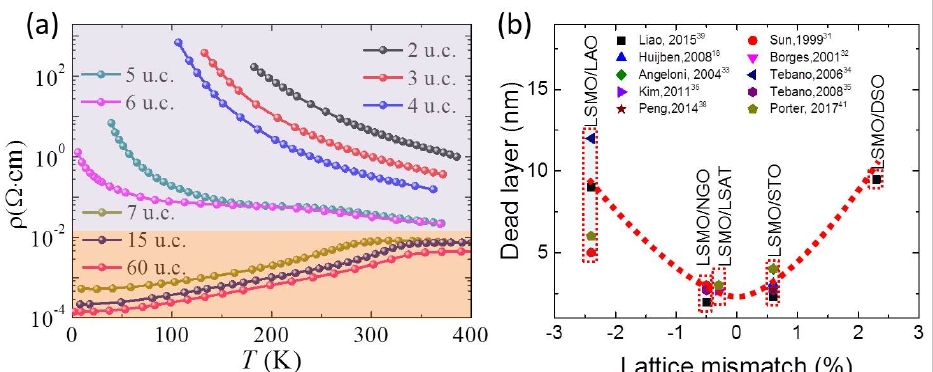
Figure 4. ( a ) Temperature-dependent resistivity of different thickness of LSMO thin films grown on STO (001) substrate. Figure is adapted from Ref. [39]. ( b ) Reported thicknesses of the dead layer of LSMO thin films grown on different substrates. ε ≡ (a Sub − a LSMO )/a LSMO .